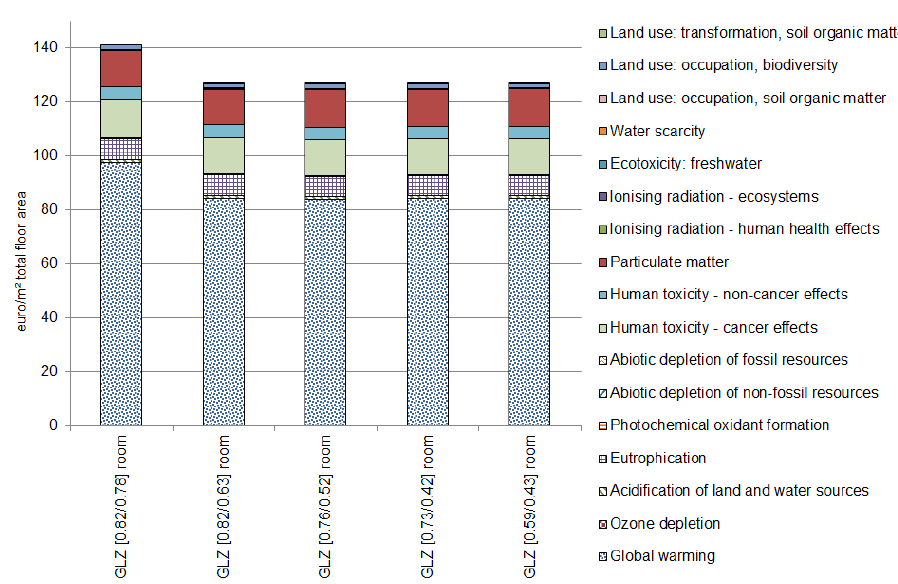
Fig. 7 Environmental impact of the patient rooms (24m 2